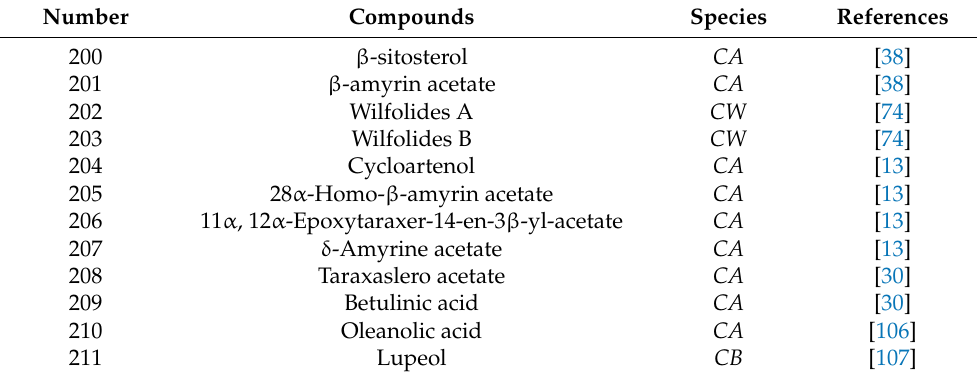
Table 3. Terpenoids compounds isolated from CA , CB , and CW .